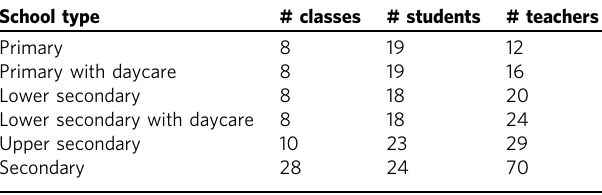
Table 2 Number of classes, students and teachers of typical schools of different school types in